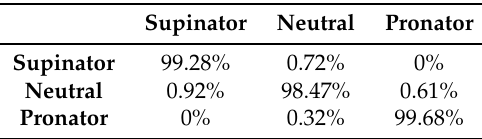
Table 4. Confusion matrix for the testing dataset.